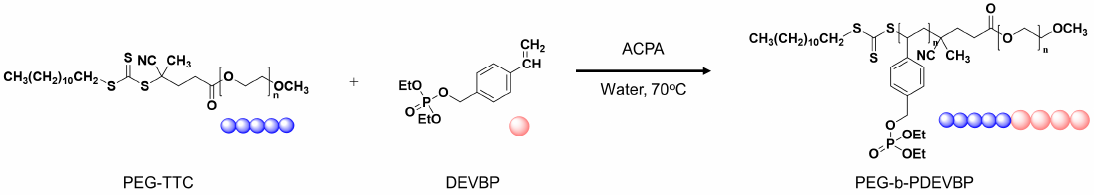
Figure 1. Synthesis of PEG-b-PDVBP.